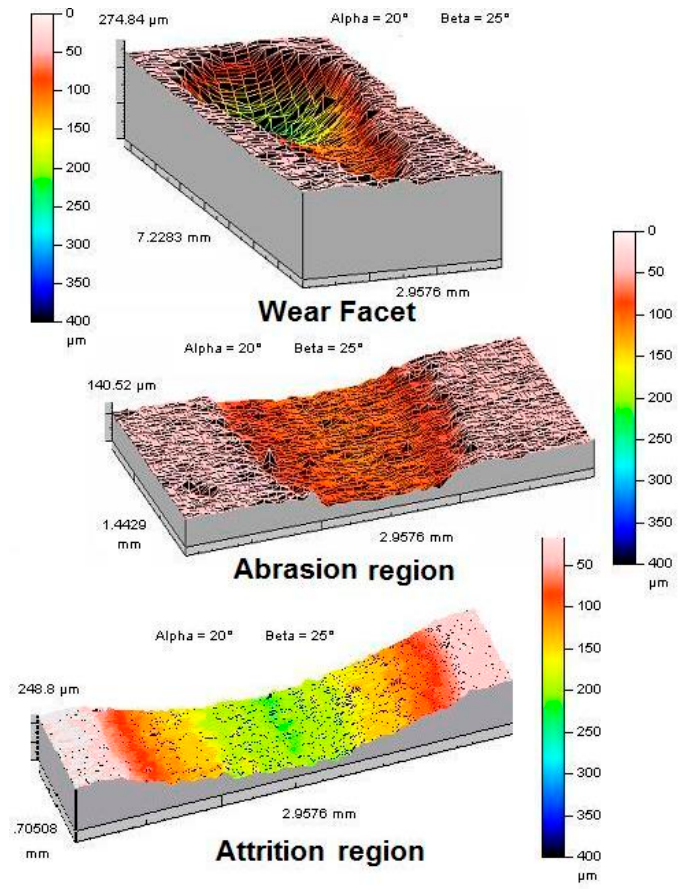
Figure 3. A tear-drop shaped wear facet produced by the OHSU wear simulator showing the abrasion and attrition regions.